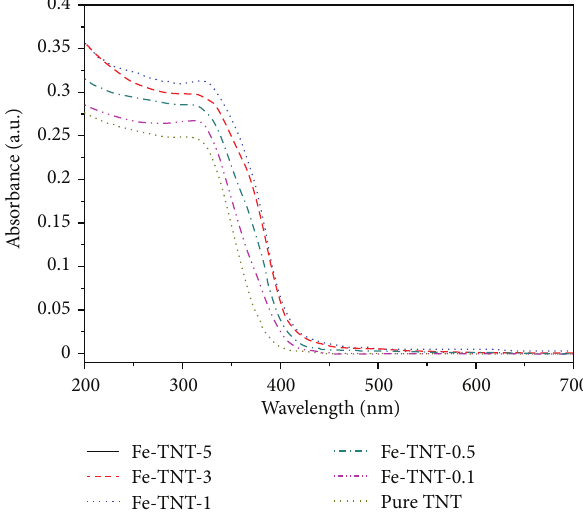
Figure 2: The XRD images of as-synthesized samples (pure TNT, Fe-TNT-0.1, Fe-TNT-0.5, Fe-TNT-1, Fe-TNT-3, and Fe-TNT-5). Figure 3: The UV-vis diffuse reflectance spectra of the as- synthesisedsamples(pureTNT,Fe-TNT-0.1,Fe-TNT-0.5,Fe-TNT-1, Fe-TNT-3, and